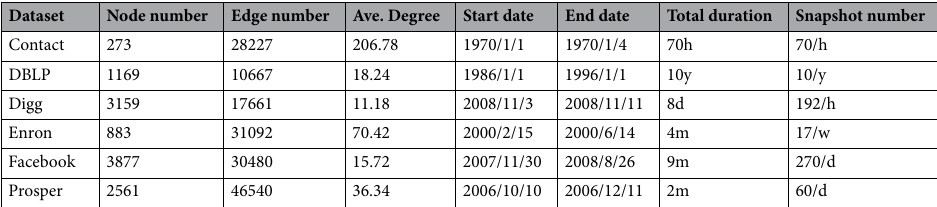
Table 2. Network datasets